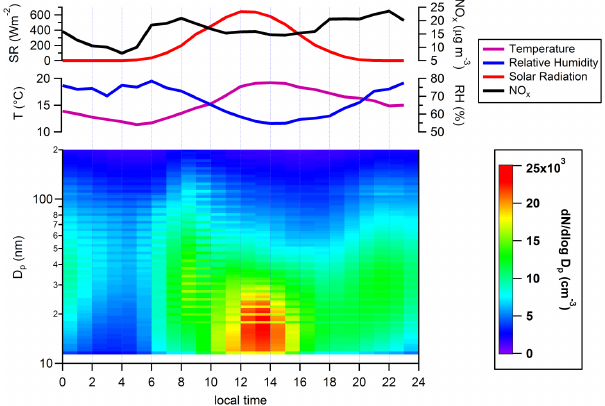
Figure 6. Daily average PN size distribution, temperature, relative humidity, solar radiation and NO x levels on a nucleation day using data from Barcelona, Madrid and Brisbane.